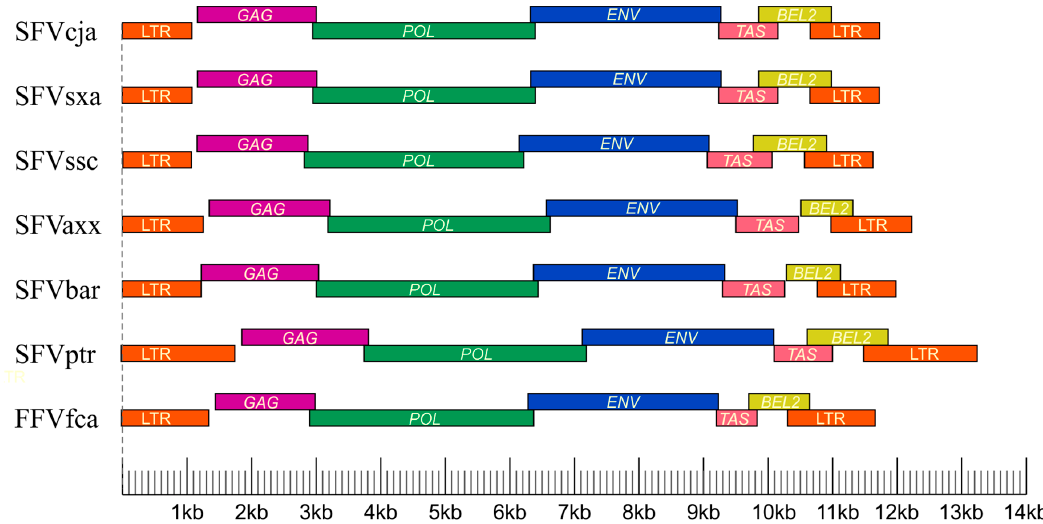
Figure 3. Structural organization of complete simian foamy virus (SFV) and feline foamy virus (FFV)